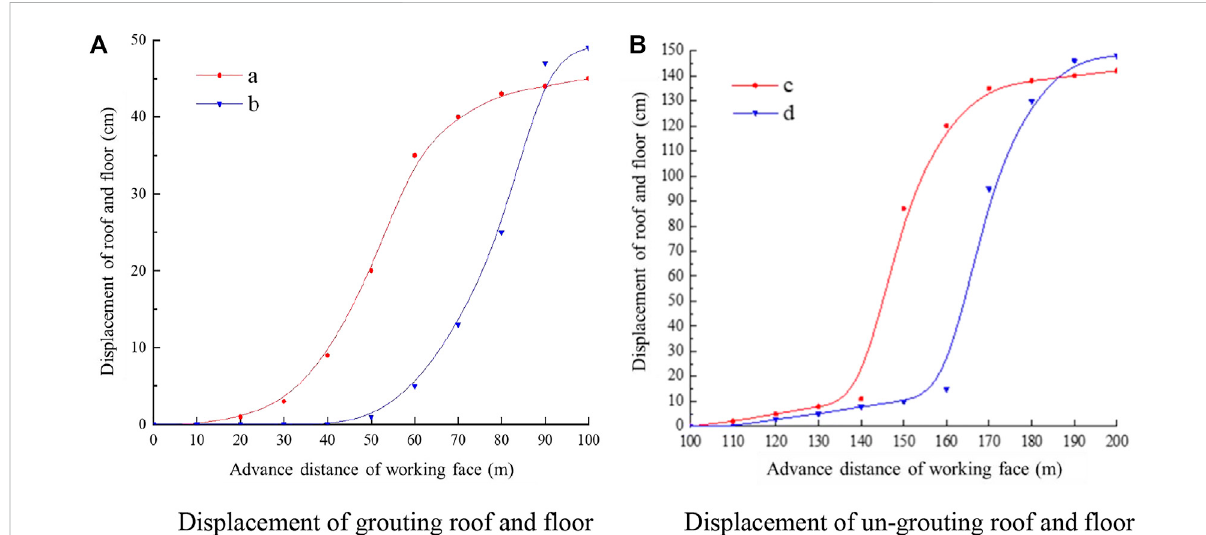
FIGURE 15 Proximity of the roof and fl oor of monitoring section.